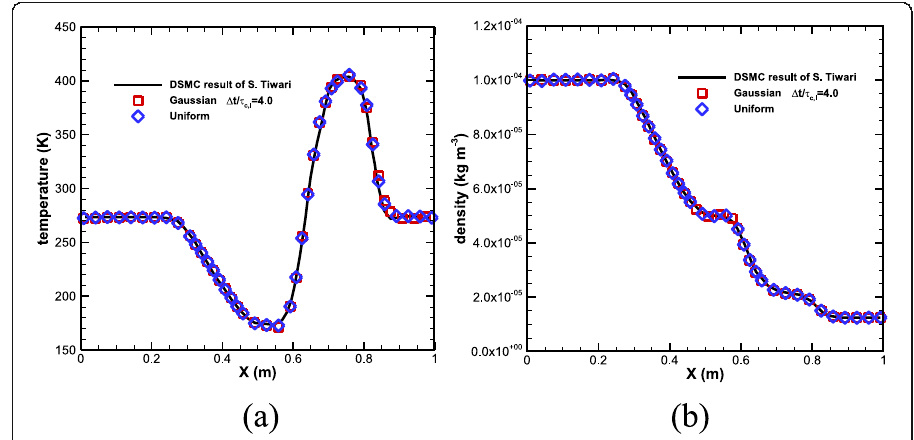
Fig. 2 (Color online) Sod tube case. a temperature and b density at the final time t final = 6.8 × 10 − 4 s . The solid lines are results of DSMC obtained by S. Tiwari [27] and the symbols refer to the efficient USP-BGK